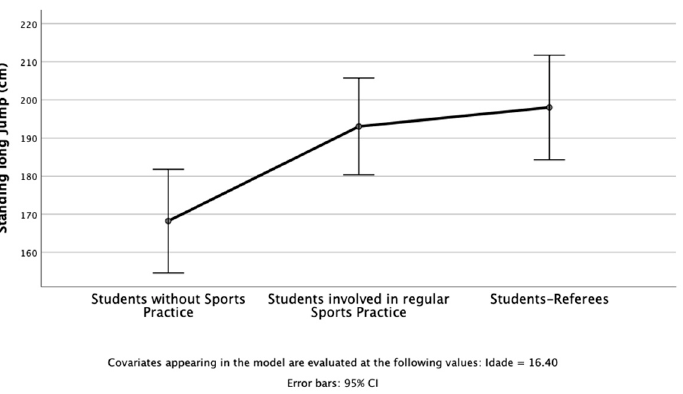
Figure 3. Students without sports practice, students involved in regular sports practice, and student referees in the standing long jump (cm).